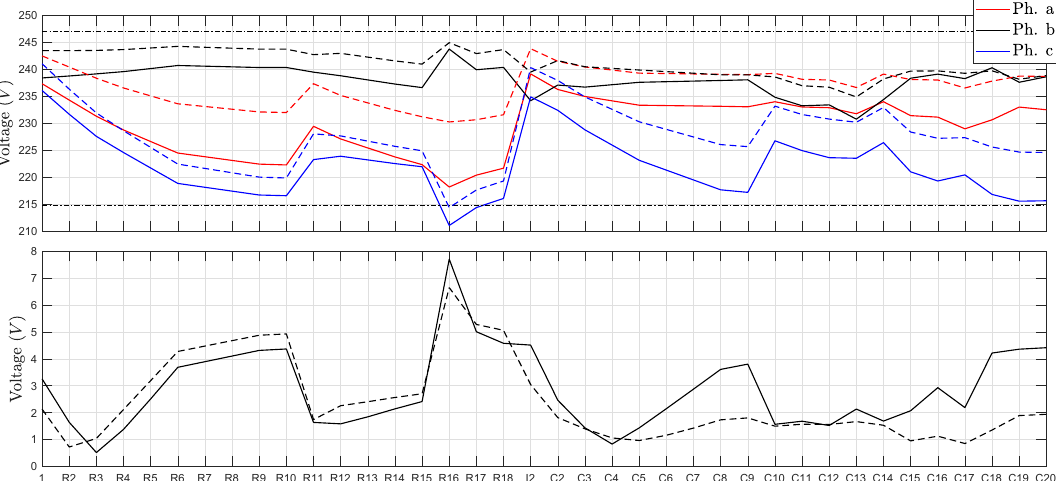
Figure 9. Simulation results when considering a 3P-OLTCST for both the accurate model and simplified model (dashed lines) of power